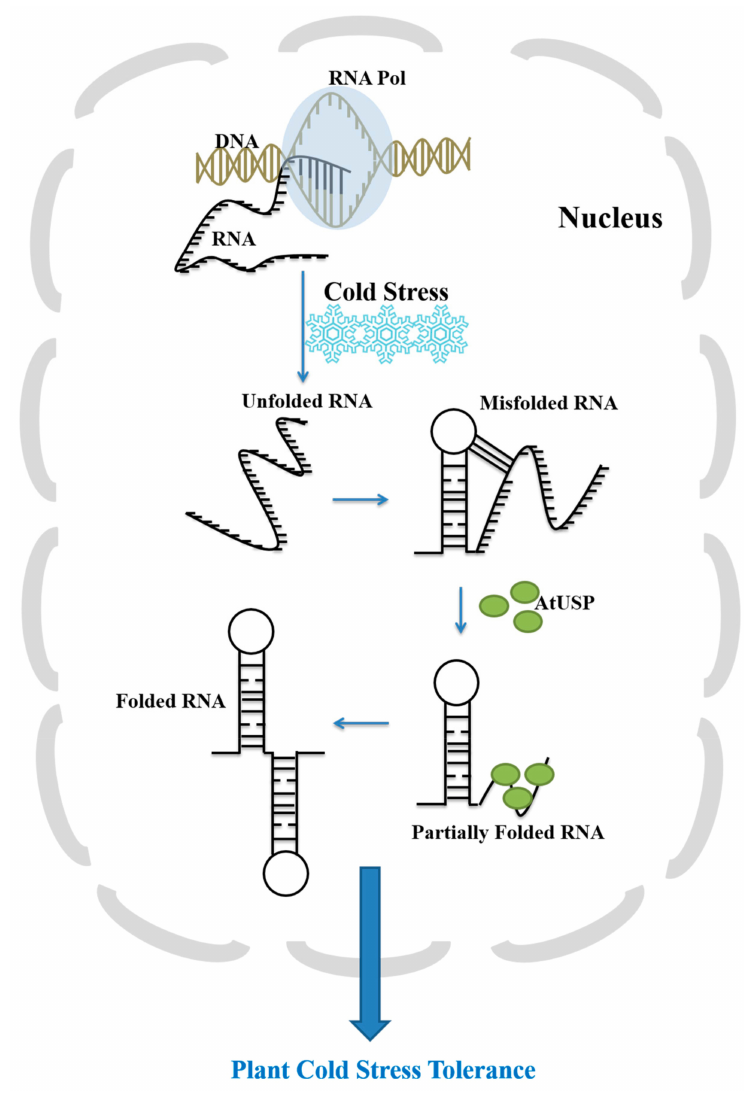
Figure 8. Proposed model of the RNA chaperone function of AtUSP. When plants are exposed to cold stress, the molecular structure of RNAs can be over-stabilized to form non-native, misfolded, and inactive conformations. AtUSP acts as an RNA chaperone and binds to the misfolded RNAs, melts the inactive conformations, and assists refolding into the native, active RNA conformations. Then, the active RNAs can be expressed to produce cold shock-resistant proteins, which enhances cold tolerance in plants. RNA Pol indicates RNA